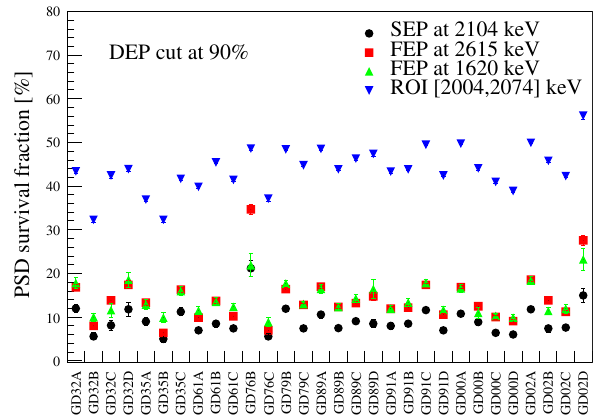
Fig. 15 Illustration of the PSD survival fractions of different 228 Th- induced γ -ray background in all 30 Gerda Phase II BEGe detectors